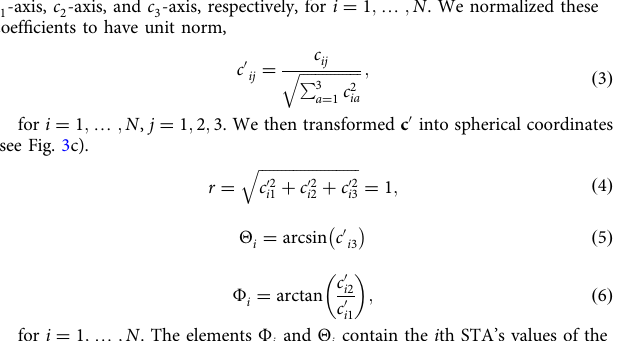
Fig. 3d was measured using a normal Gaussian kernel smoothing function (MATLAB, Statistics and Machine Learning Toolbox function ksdensity with bandwidth parameter equal to 10° for Φ and 3° for Θ ). Each population average shown in Fig. 3g is constructed by averaging together all non-normalized STAs triggered to saccades to the left with a speci fi c value of ϕ . For example, the average under the column ϕ = 105 was constructed by fi rst fi nding the STAs triggered to saccades to the left with ϕ within 15° of 105 and then averaging these together. Letting f i ; : denote the i th STA and S 105 denote the set of integers that index leftward STAs with ϕ = 105, S 105 ¼ (cid:7) i j 97 : 5 ≤ Φ i < 112 : 5 ;